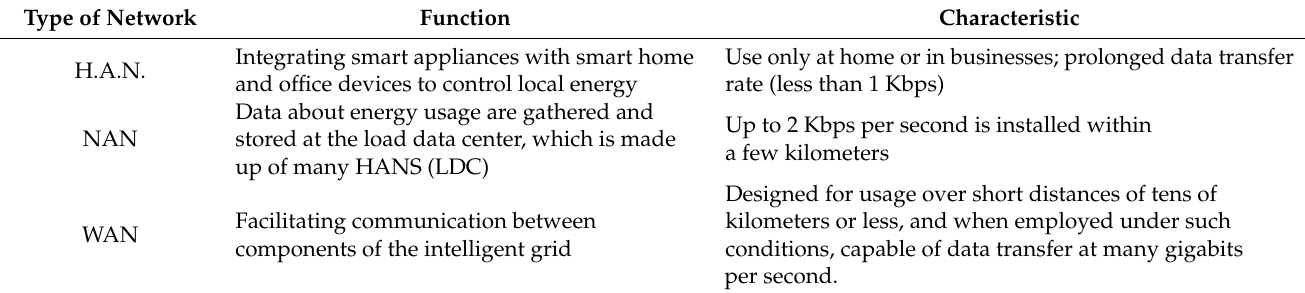
Table 3. Types of networks and their